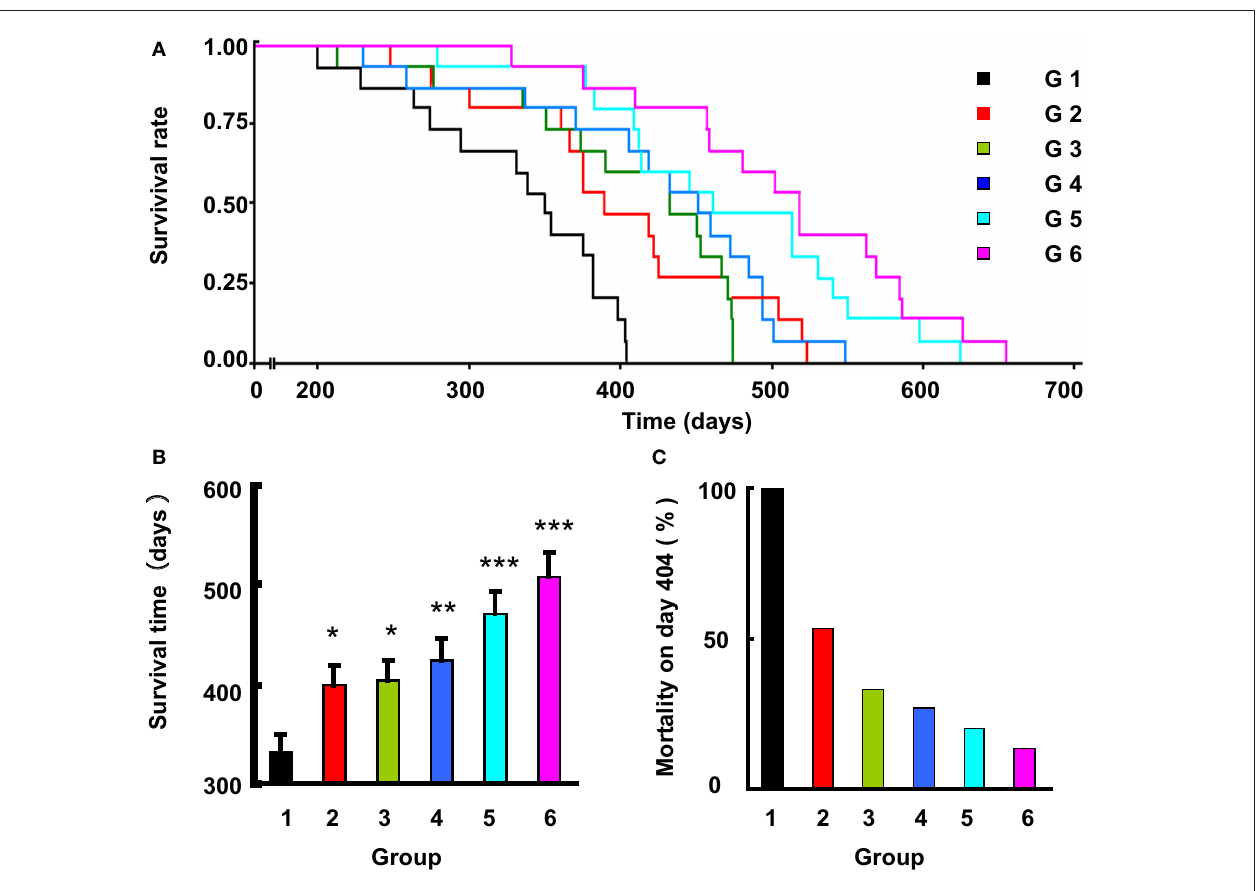
FiGure 2 | The effects of life-long treatment of ketanserin (Ket) and amlodipine (Aml) on the stroke death in SHr-SP. (A) The survival rate in these six subgroups (G, group), doses referred to Table 1 , is expressed by Kaplan-Meier